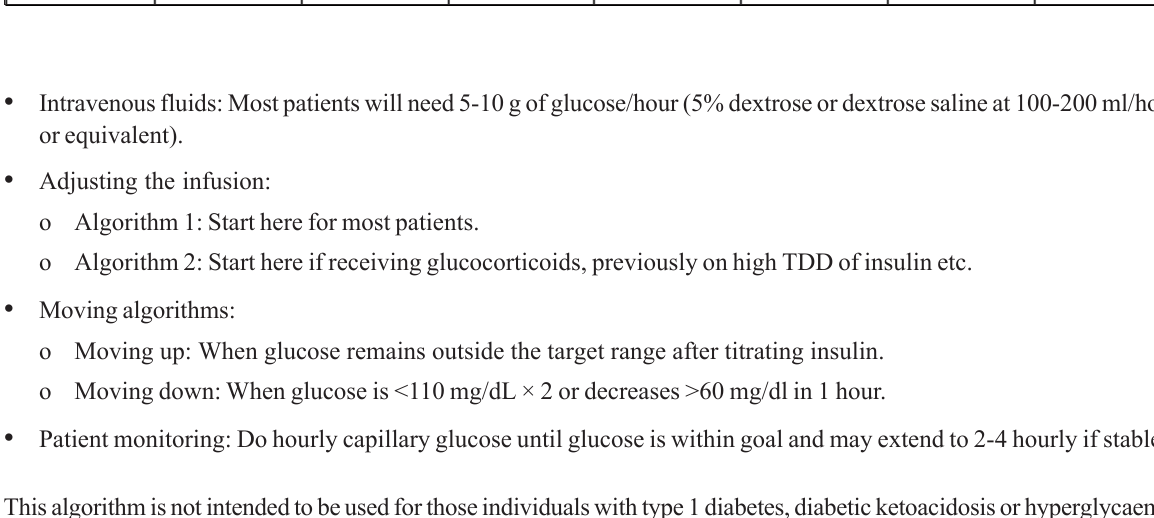
This algorithm is not intended to be used for those individuals with type 1 diabetes, diabetic ketoacidosis or hyperglycaemic hyperosmolar